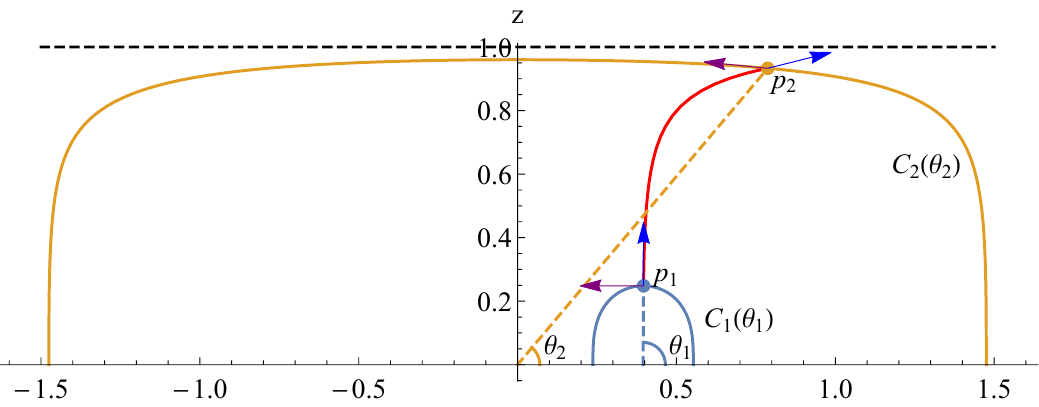
Figure 10 . Schematic diagram of solving EWCS. The inner blue curve C 1 ( θ 1 ) and the outer orange curve C 2 ( θ 2 ) in the figure are the corresponding minimum surfaces with widths of b and a + b + c respectively. The red curve is the minimum surface connecting p 1 on C 1 and p 2 on C 2 . There are blue and purple arrows at p 1 and p 2 , representing the tangent vector along the red curve and the tangent vector along C 1 or C 2 . The horizontal black dashed line represents the horizon of the black